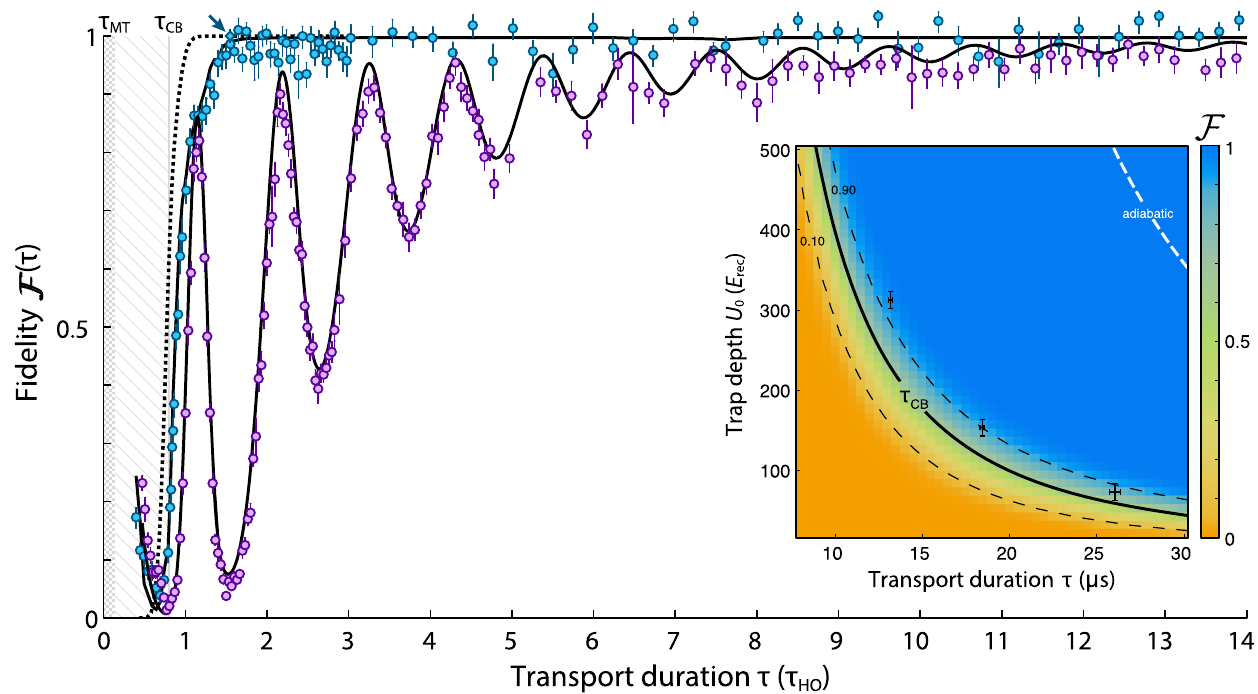
FIG. 2. Revealing the quantum speed limit. The fidelity F ð τ Þ of transporting an atom over one lattice site is measured as a function of ≈ 20 μ s, for a trap depth U ≈ 150 E the transport duration τ , expressed in units of the oscillation period τ . Blue points: optimal 0 HO rec (diamond point marked by an quantum control achieves near-unit fidelity for durations above the quantum brachistochrone time τ QB arrow), in the proximity of τ . Hatched area: low-fidelity region as expected for durations shorter than the classical brachistochrone HO time τ ; see Sec. VII. Dotted area: low-fidelity region predicted by the Mandelstam-Tamm bound τ . Purple points: linear transport CB MT ramps achieve suboptimal fidelity. Black lines: computed fidelity based on numerical simulations of atom transport, assuming a transverse temperature T ⊥ ≈ 1 μ K (solid) and a zero-temperature case (dashed). Inset: the fidelity landscape computed numerically as a function of U 0 and τ for T ⊥ ¼ 0 (colored contour map) and the measured transition points (experimental data) where the fidelity reaches F ≈ 0 . 5 . White lines: the oscillation period τ , approximately representing the quantum brachistochrone time τ , and the adiabatic HO QB limit ensuring fidelities F > 0 . 9 . Error bars represent one standard